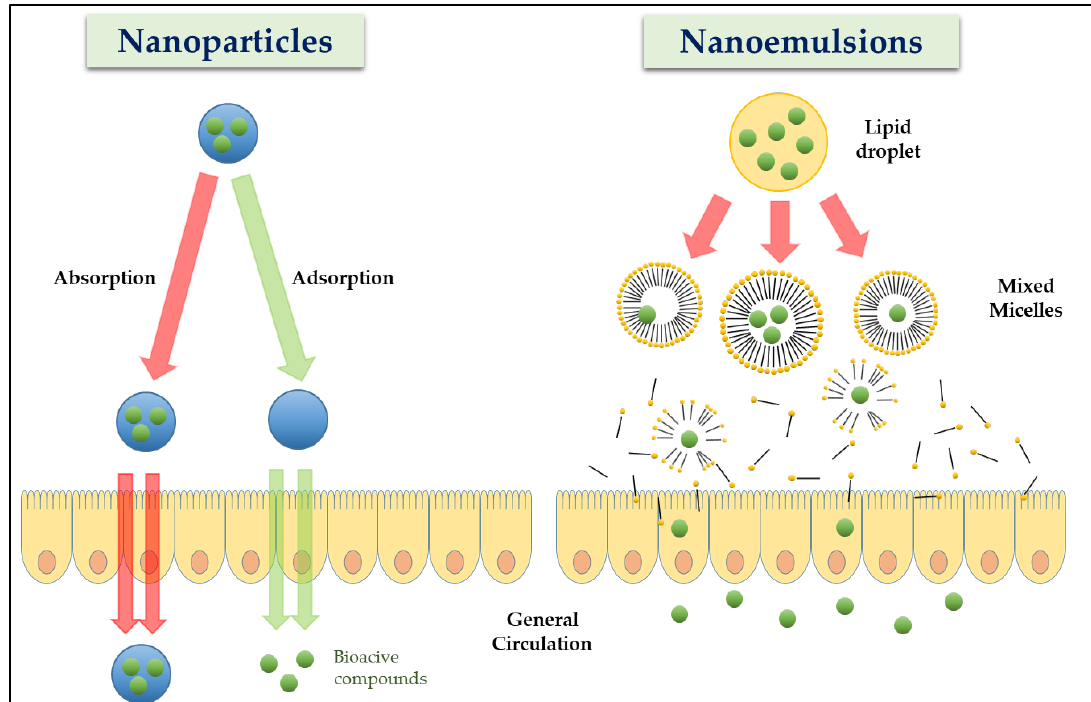
Figure 3. Schematic representation of different absorption mechanisms of bioactive compounds encapsulated in nanoparticles and nanoemulsions. Adapted and modified from Chen et al. [6].